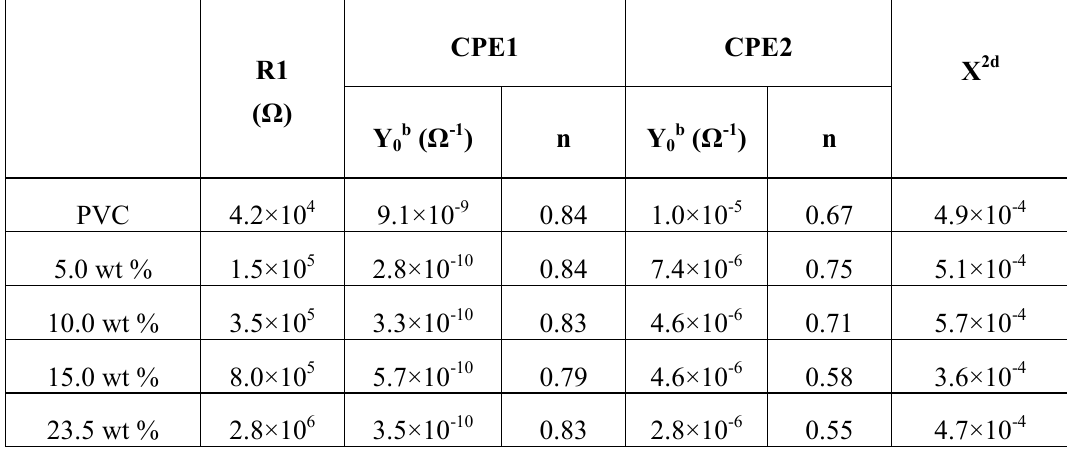
Table 2 . Values of the parameters of the equivalent circuit simulated for PVC-SR film.